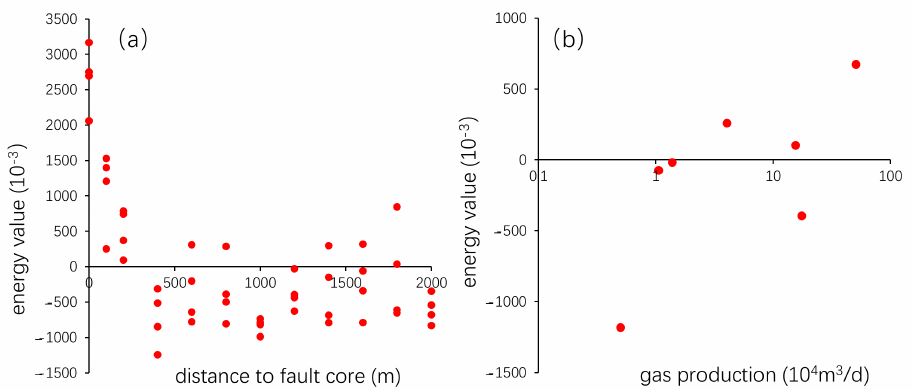
Figure 7. Energy value from anisotropic energy vs. distance to fault core ( a ) and vs. gas production ( b ) in the carbonate platform